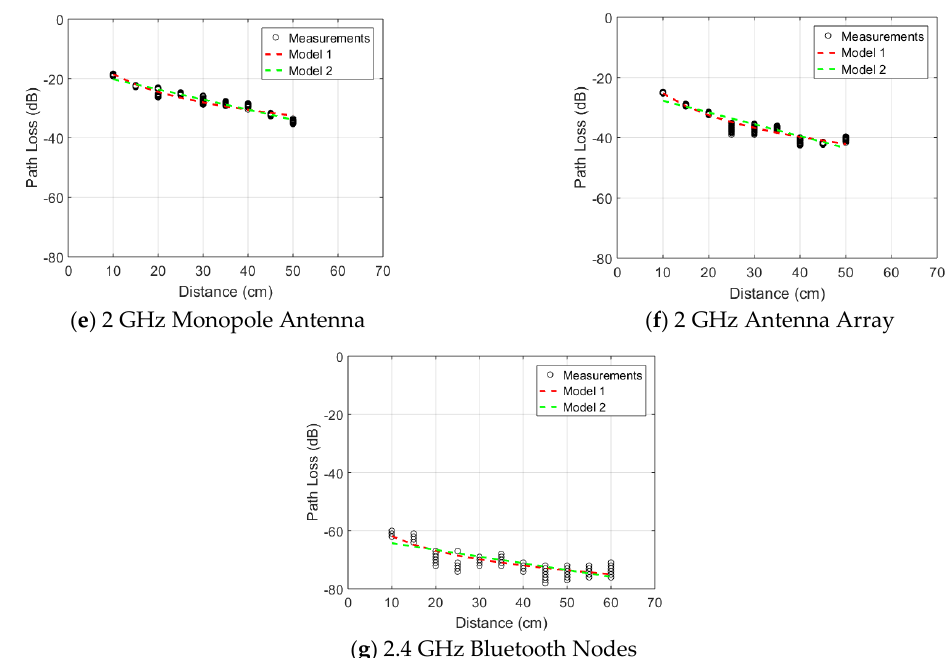
Figure 9. Measured path loss as a function of distance in the reference scenario (left arm). Measurements are shown as black markers, alongside two fits using the two considered path loss models for the seven studied technologies: ( a ) 450 MHz monopole, ( b ) 450 MHz BCC, ( c ) 915 MHz folded dipole parallel to the body, ( d ) 915 MHz Folded dipole orthogonal to the body, ( e ) 2 GHz Monopole antennas, ( f ) 2 GHz Dipole Arrays, and ( g ) 2.4 GHz Bluetooth nodes.